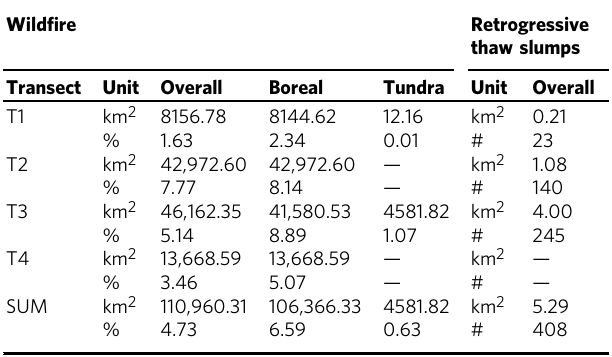
Table 2 Regional statistics of wild fi res and retrogressive thaw slumps per study